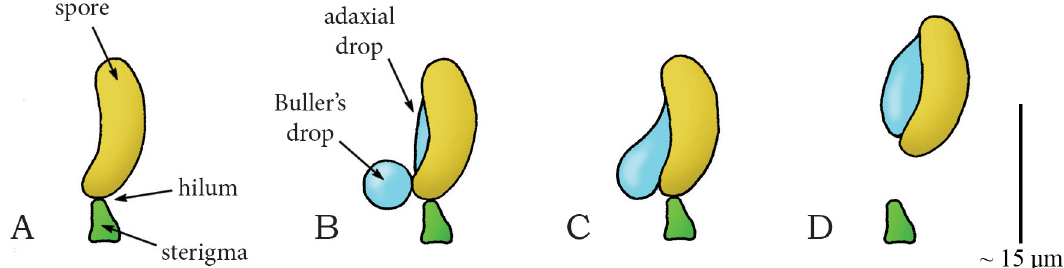
Fig 2. Momentum catapult mechanism in the phylum Basdiomycota (species Auricularia auricular ). (A) The sporogenous cell of Basdiomycota before discharge with the spore attached to the sterigma at the hilum. (B) By secreting osmolytes, Buller ’ s drop and the adaxial drop grow on the surface of the spore. (C) When Buller ’ s drop reaches a critical size, the two drops coalesce, generating a compression force on the sterigma. (D) A rapid shift of the joint center of mass of the spore and the coalesced drops puts tension on the hilum. When a critical tensile stress is reached, the hilum breaks and the spore (together with the coalesced drops) is discharged. Drawings based on schematic drawings in [34]. Scale bar 15 micrometer [ μ m].